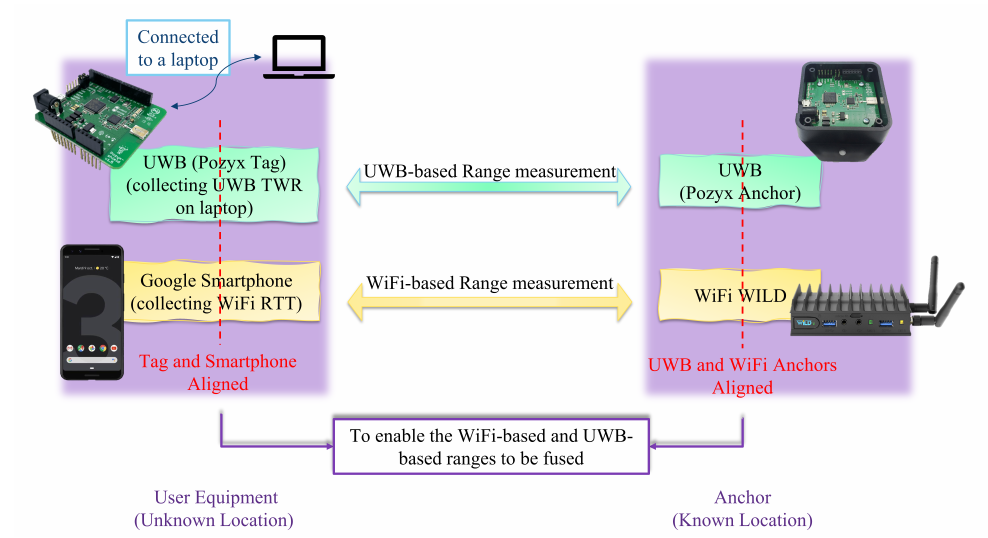
Figure 8. Range measurement using the anchors and User Equipment